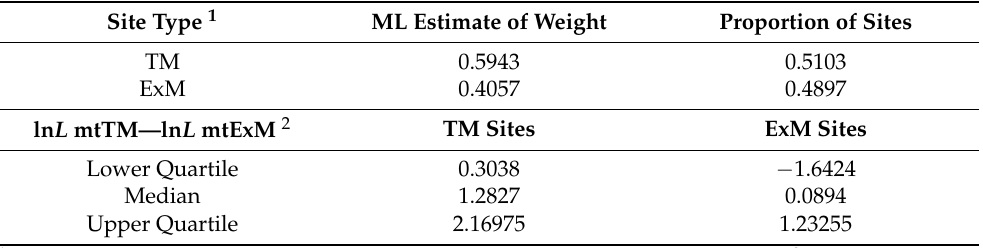
Table 2. Mixture weights and contribution of each mixture component to site